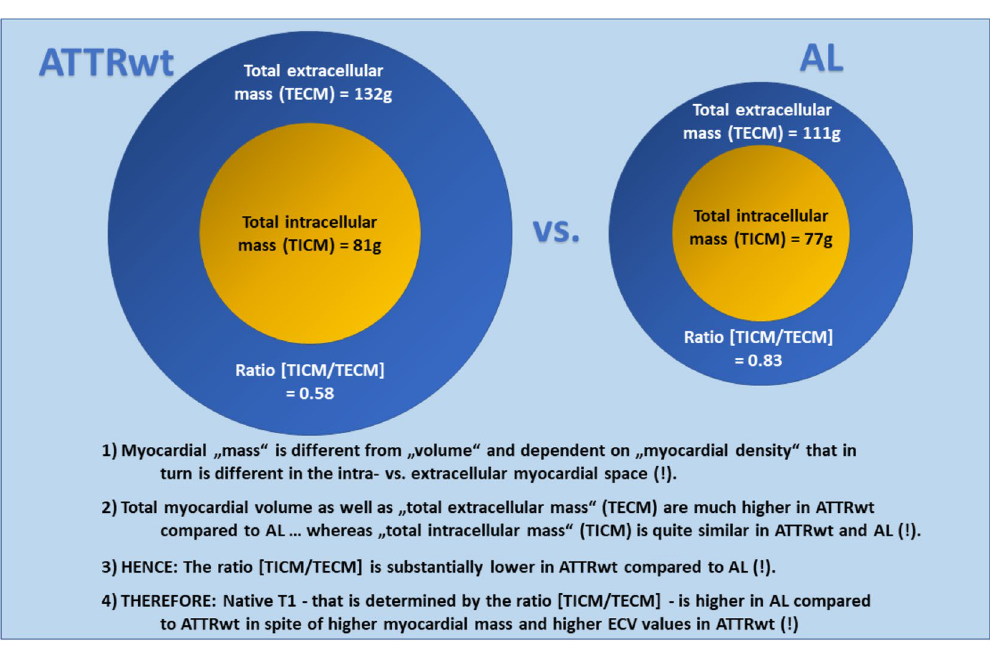
Figure 4. Central illustration of the major study